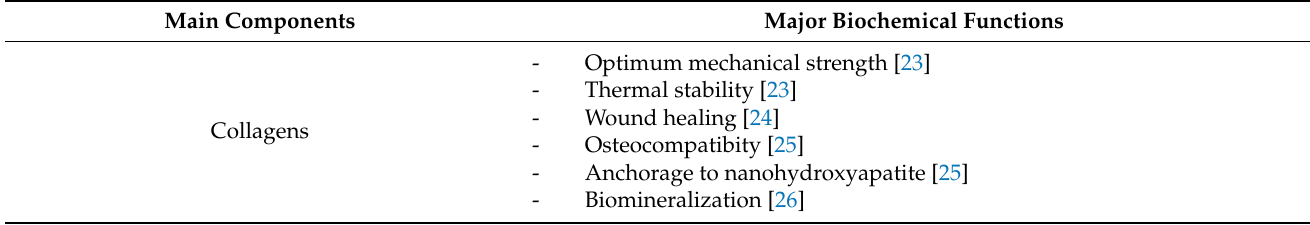
Table 1. Main chemical components of the eggshell membrane and their